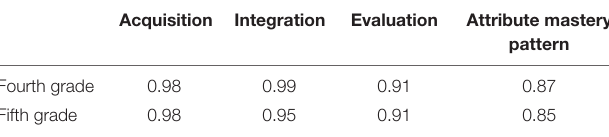
TABLE 7 | The Q matrix of empirical data. TABLE 8 | The classification accuracy of supervised self-organizing